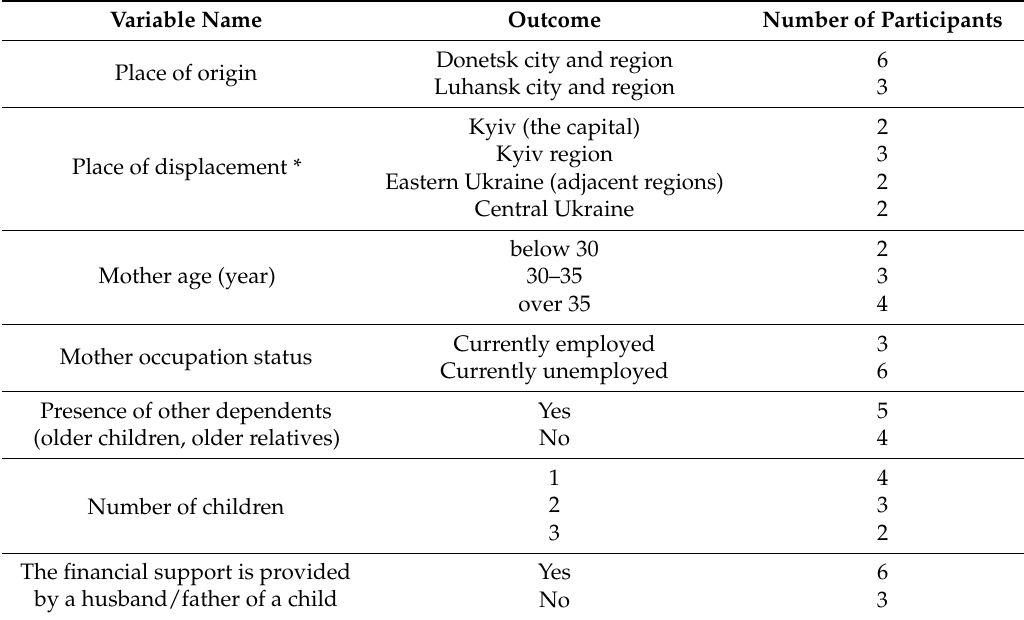
Table 1. Selected socio-demographic characteristics of the interviewed IDP